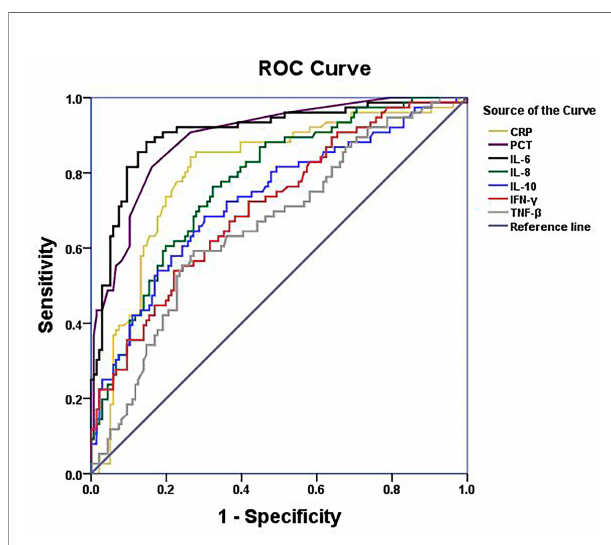
FIGURE 2 | ROC curves of serum CRP,PCT, IL-6, IL-8, IL-10,IFN- g and TNF- b levels of NHL patients with bacterial respiratory infection.